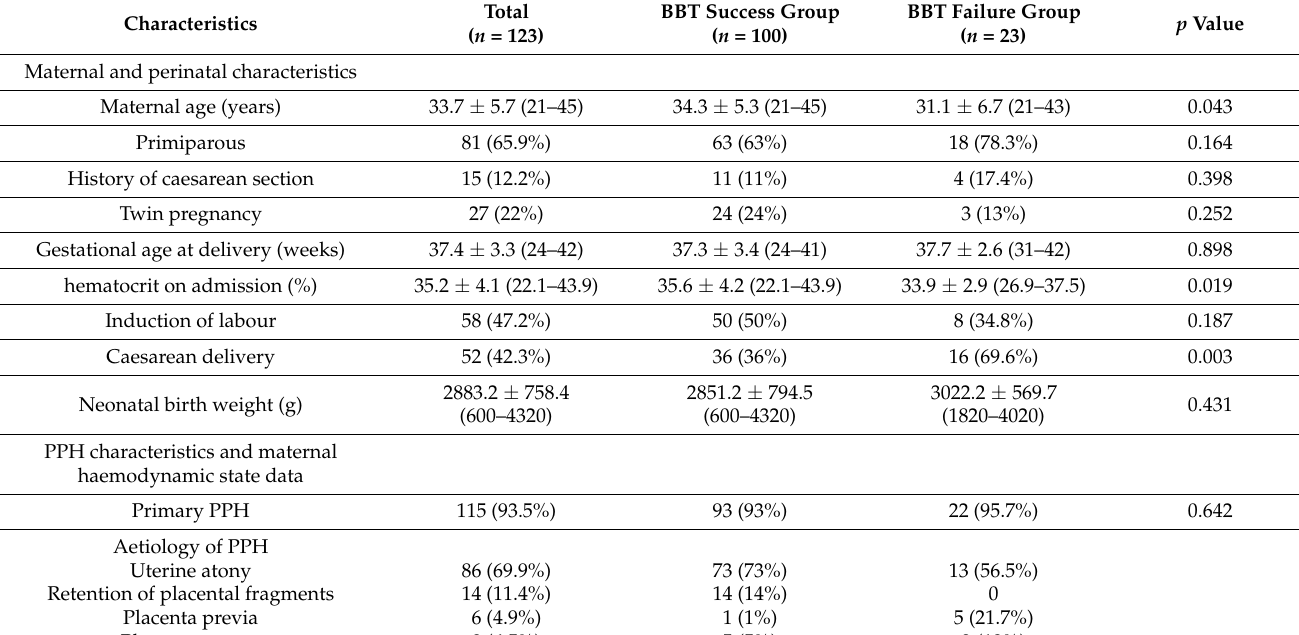
Table 1. Clinical characteristics of women managed with Bakri Balloon Tamponade (BBT) for postpartum haemorrhage (PPH) in the study hospital ( n = 123). Comparison between successful and failed management with BBT.